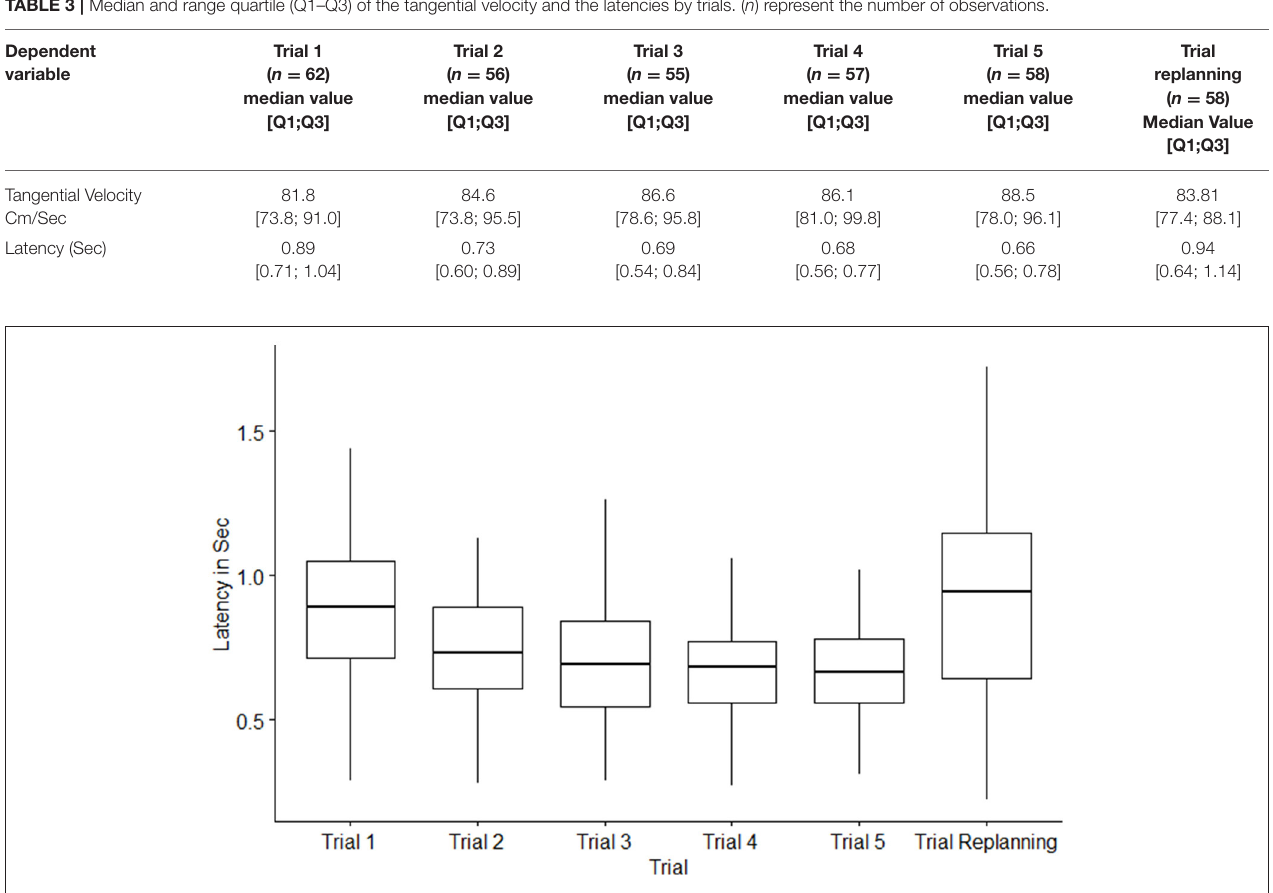
FIGURE 6 | Boxplot of latency in Sec by trials (Leaning and replanning). Box = 25th and 75th Percentiles; bars = min and max values.